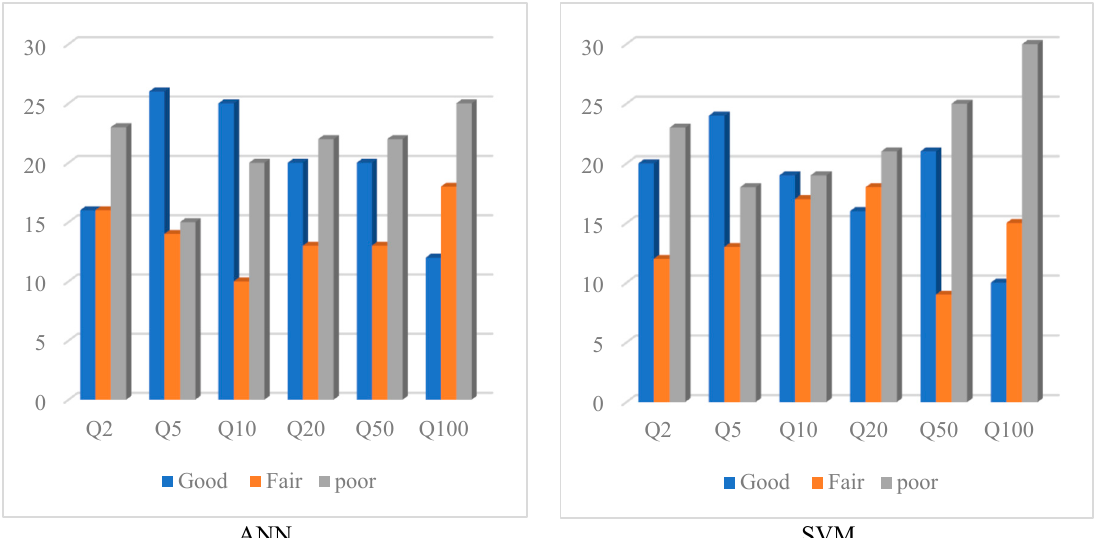
Figure 9. Number of stations (testing dataset) based on REr values for the ANN and SVM models. In terms of the cumulative percentage of stations based on Abs RE values, shown in Figure 10, both models perform very similarly, with the ANN method performing slightly better than the SVM for all the return periods, where the curve for ANN is above the SVM, except for Q 2 , showing that the ANN method performs better for a greater number of test catchments with lower ranges of Abs RE